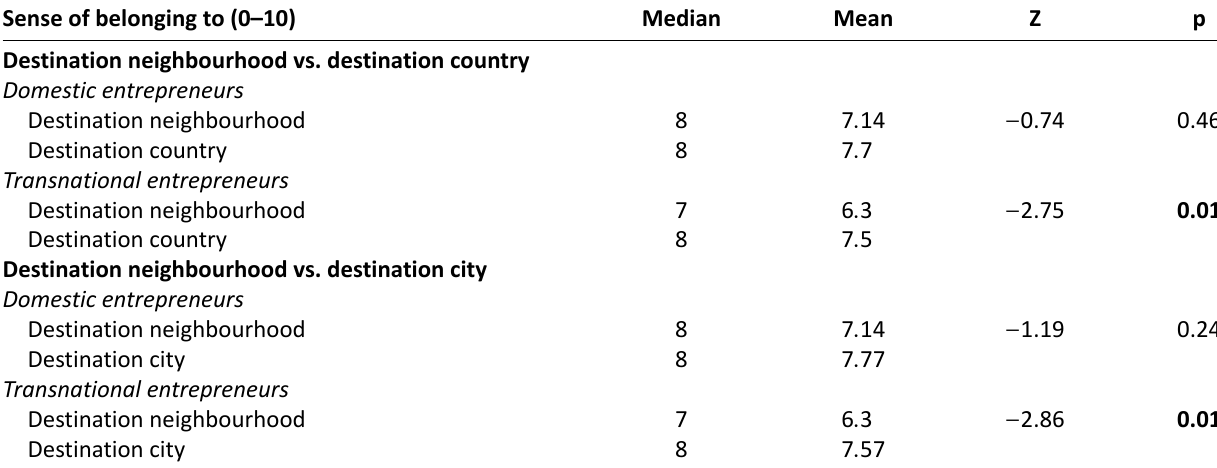
Table 4. Comparison between the sense of belonging towards different places. Sense of belonging to